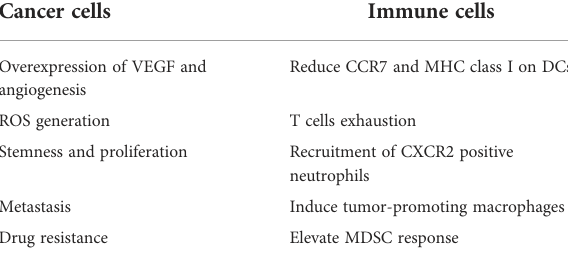
TABLE 1 Effects of high cholesterol levels on cancer cells and immune